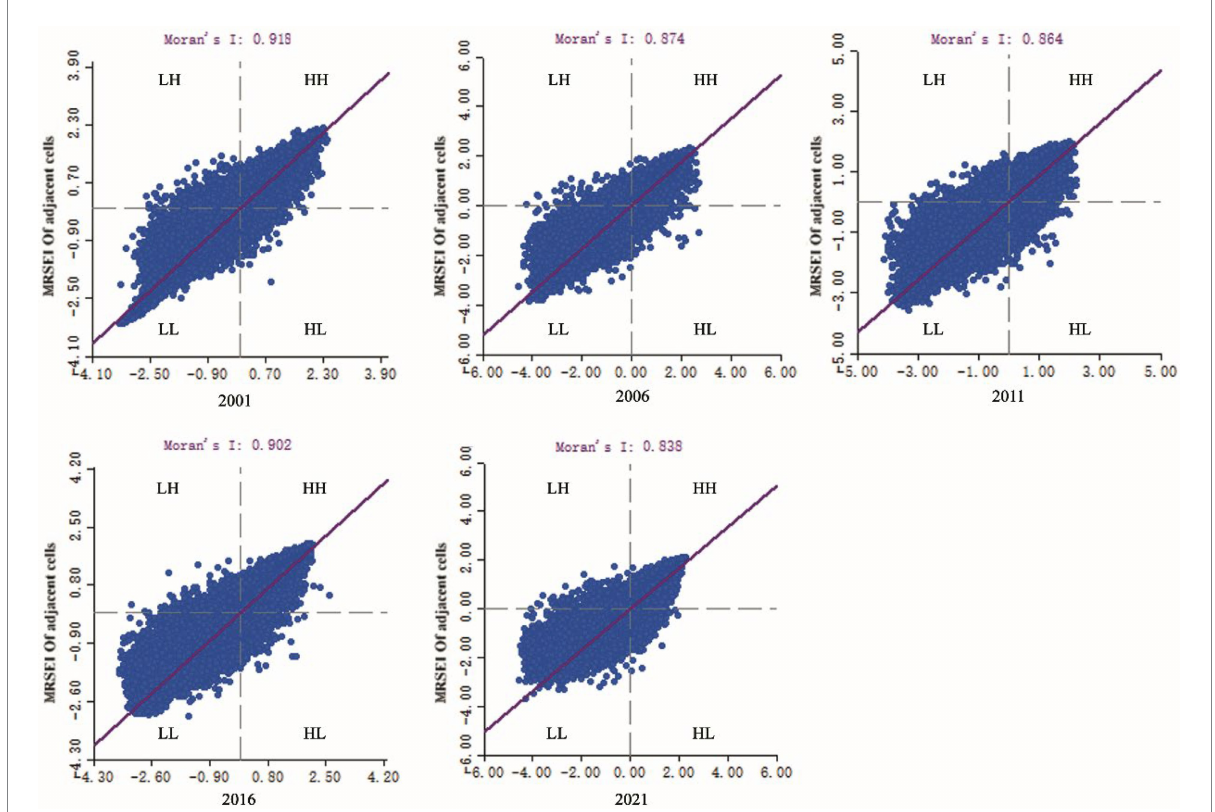
FIGURE 8 Moran scatter plots of the MRSEI in Yangtze River Delta Urban Agglomeration from 2001 to